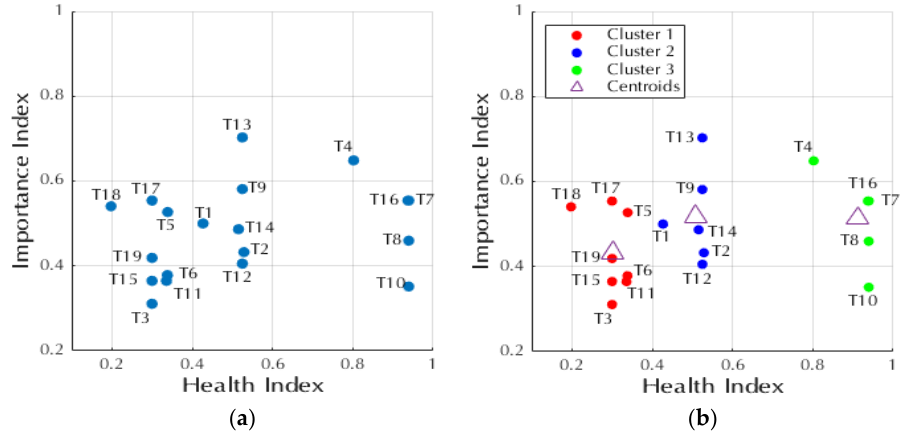
Figure 12. ( a ) Transformers fleet in the risk matrix.; ( b ) Transformers fleet in the risk matrix with k- means clustering technique